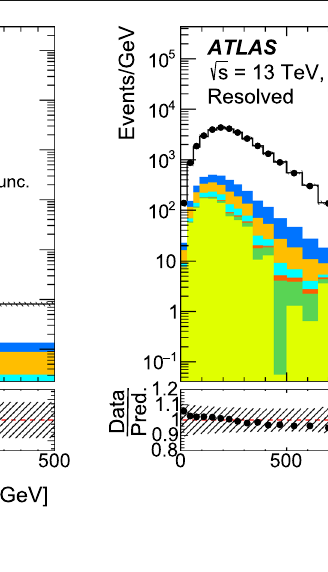
Fig. 11 Kinematic distributions in the (cid:3) + jets channel in the resolved sents the combined statistical and systematic uncertainties (described in Sect. 9) in the total prediction, excluding systematic uncertainties topology reconstructed with the pseudo-top algorithm at detector-level: | and b scalar relatedtothemodellingofthe t ¯ t events.Underflowandoverflowevents, a absolute value of the out-of-plane momentum | p t , had out if any, are included in the first and last bins. The lower panel shows the sum of the transverse momenta of the hadronic and leptonic top ratio of the data to the total quarks H t ¯ t . Data distributions are compared with predictions, using T Powheg + Pythia8 as the t ¯ t signal model.The hatched area repre-